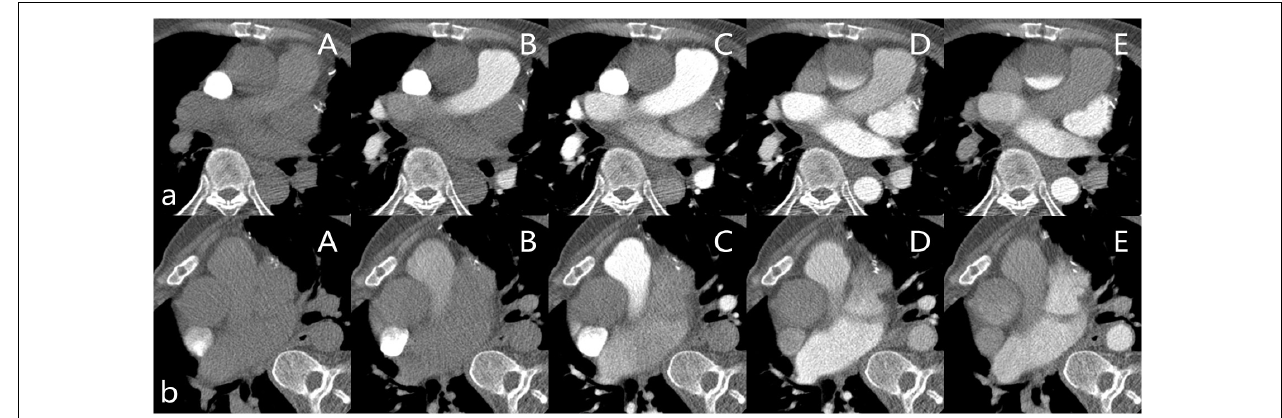
FIGURE 1 | (a) Patient in the supine position. (A–E) are the slices of the AAO after the contrast agent injects 9s, 13s, 18s, 23s, and 28s in the Smart Prep Series. (b) Patient in the right lateral decubitus position. (A–E) are the slices of the AAO after the contrast agent injects 9s, 13s, 18s, 23s, and 27s in the Smart Prep Series.